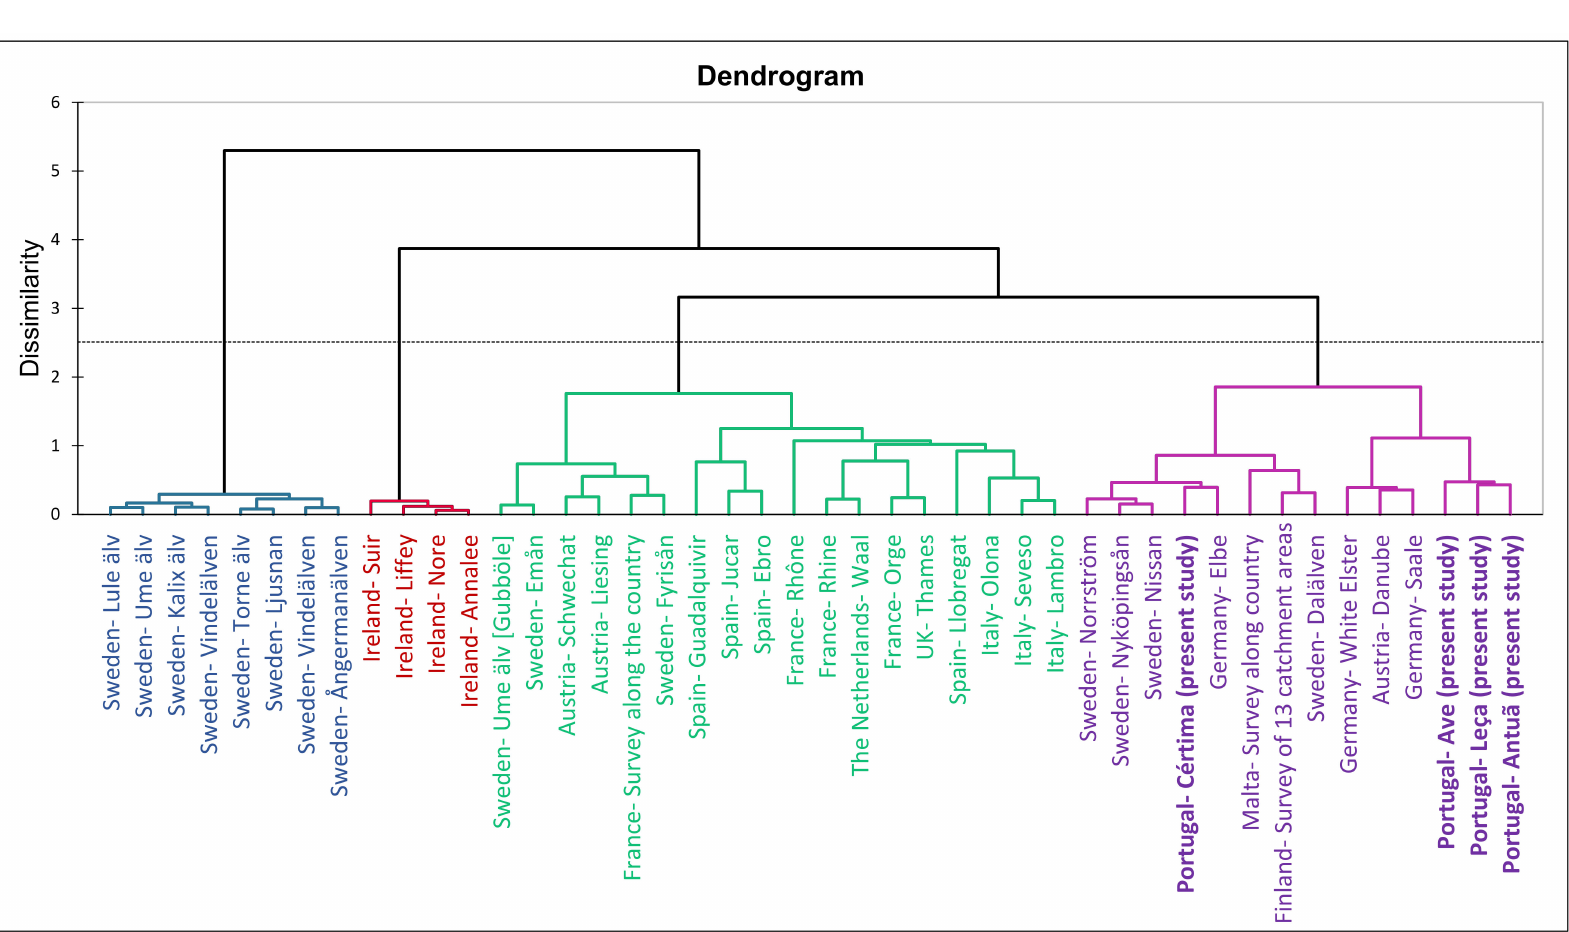
Figure 3. Hierarchical cluster analysis of different studies of PFASs in European SWs. The four river basins of this study are indicated in bold type. References: Sweden [57]; Ireland [56]; Austria [34]; France—Survey along the country [20]; Spain—Guadalquivir and Ebro [58]; Spain—Jucar [59]; France—Rh ô ne and Rhine [46]; The Netherlands [60]; France—Orge [38]; UK—Thames [61]; Spain—Llobregat [62]; Italy [33]; Germany [63]; Malta [64];